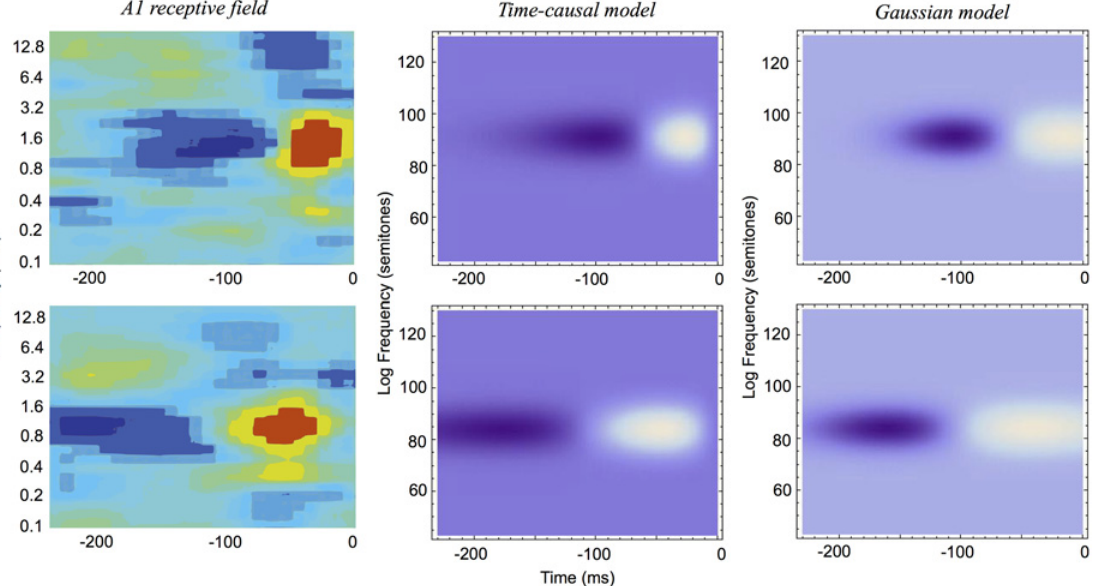
Fig 18. (left column) Separable spectro-temporal receptive fields in the primary auditory cortex (A1) of Sprague Dawley rat as reported by Machens et al. [37] (schematic simplification only, see figs. 5(a) and 5(c) in [37] or fig. 19 in [64] for the original data). (middle and right columns) Idealized receptive fields models (90) corresponding to first-order derivatives with respect to time, in the top row centered at semitone ν = 91, temporal scale σ t = 45 ms, logspectral scale σ ν = 6 semitones for both models and additionally temporal delay δ = 60 ms for the Gaussian model and in the bottom row centered at semitone ν = 84, temporal scale σ t = 60 ms, logspectral scale σ ν = 6 semitones for both models and additionally temporal delay δ = 100 ms for the Gaussian model